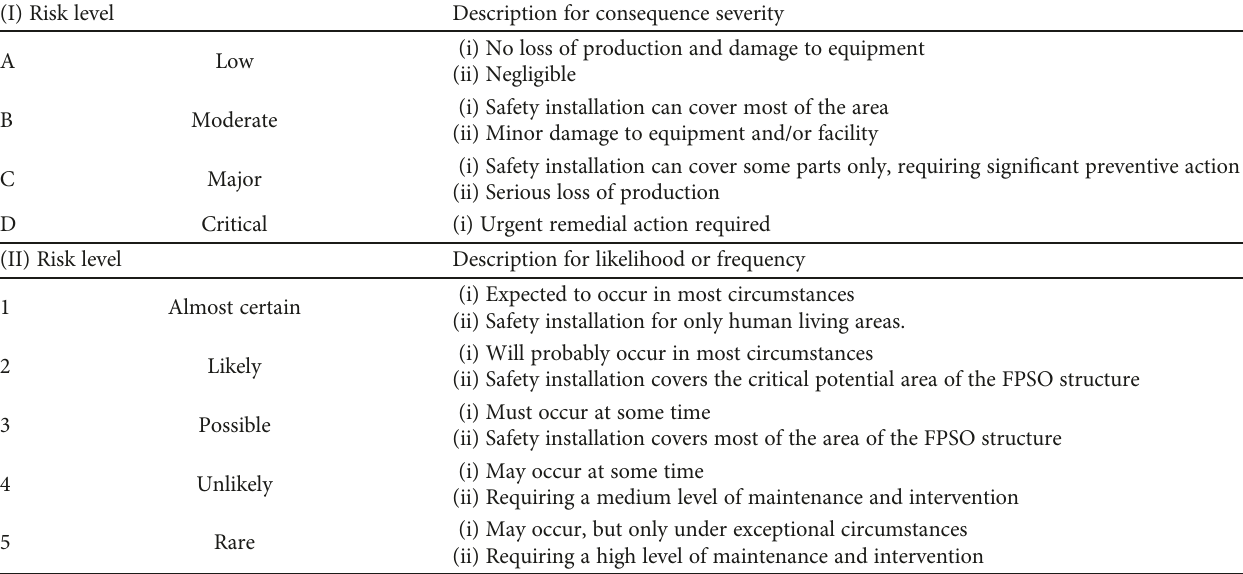
Table 1: Risk screening index considering safety